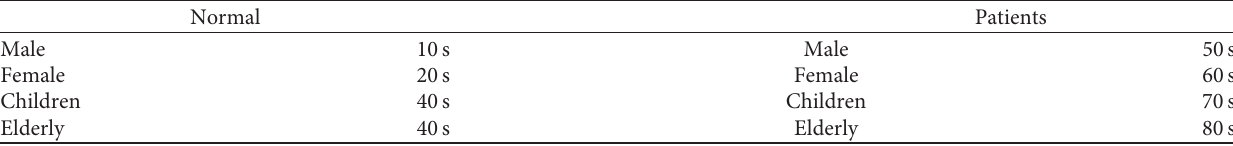
Table 16: Reaction time of different pedestrians.